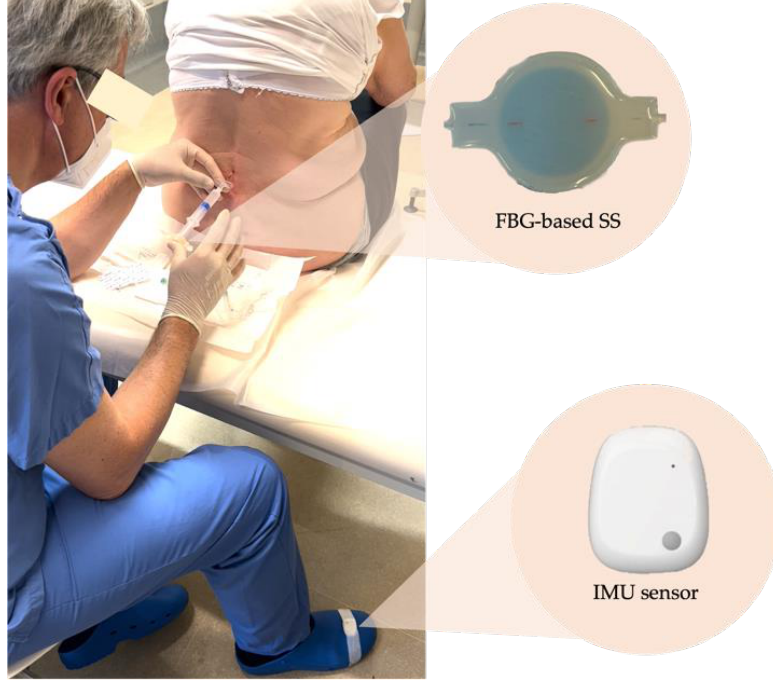
Figure 6. Experimental set-up of one of the epidural procedures performed.